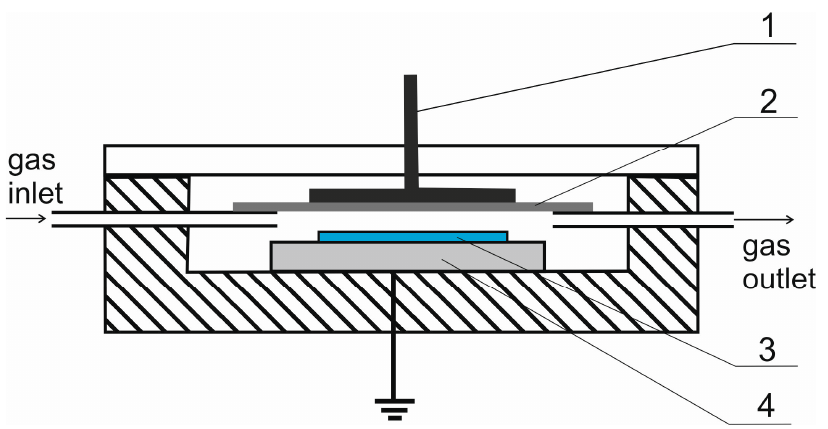
Figure 1. Diagram of a barrier discharge plasma reactor: 1—high voltage electrode, 2—quartz barrier, 3—rubber sample, 4—grounded electrode.